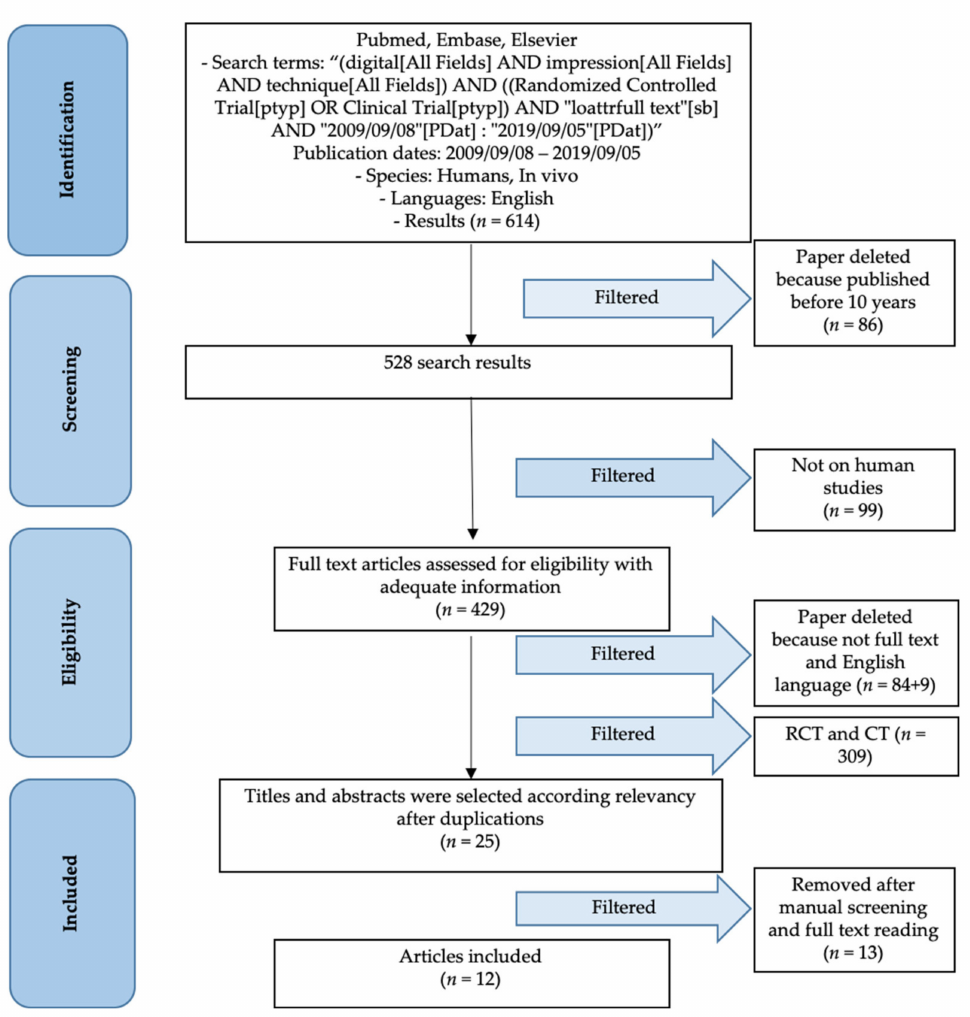
Figure 1. PRISMA flow